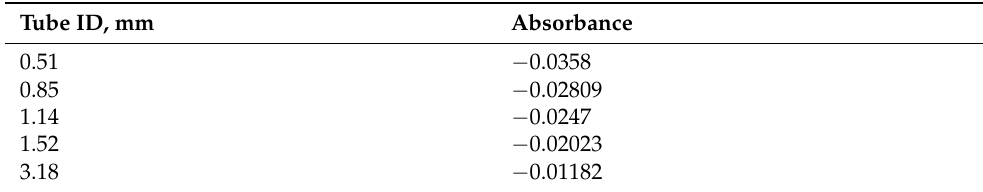
Figure 8. Effect of the tube inner diameter on the absorbance of Cu-PCV. The sample flow rate of 3.5 mL min − 1 , CTAB concentration of 30 µ g mL − 1 , sample volume 200 µ L, and measurement at 430 nm. Table 2. Variation of absorbance of Cu-PCV with the inner diameter of the conducting Tygon